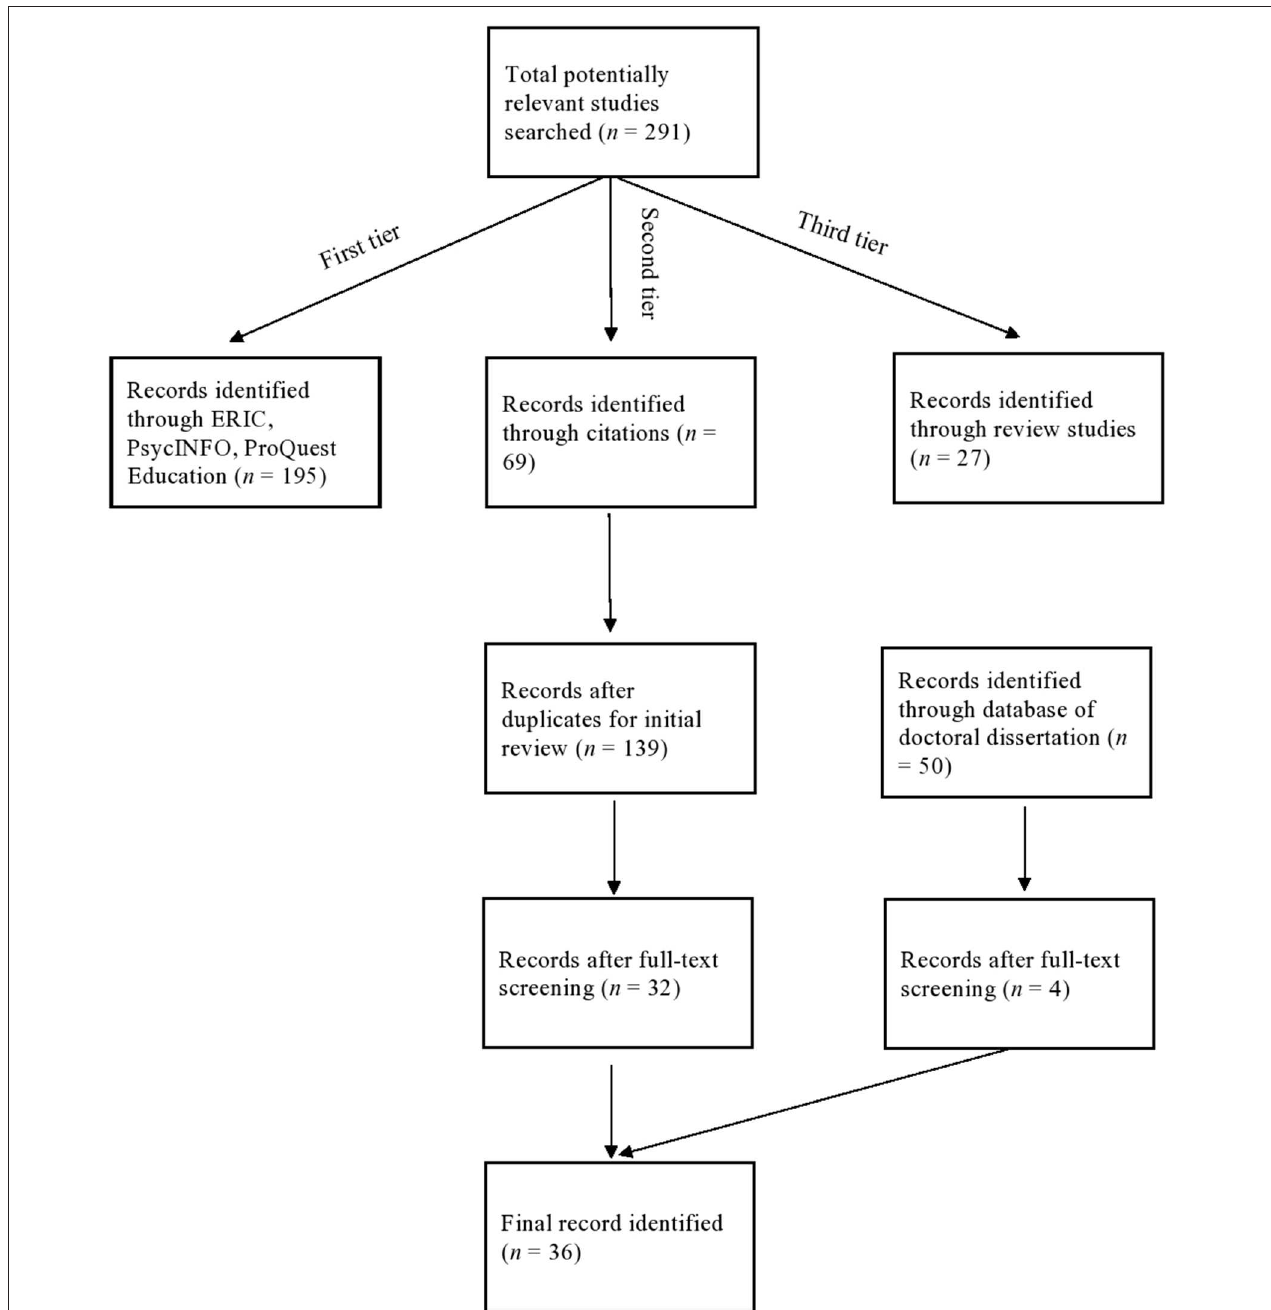
FIGURE 1 | Flowchart of article